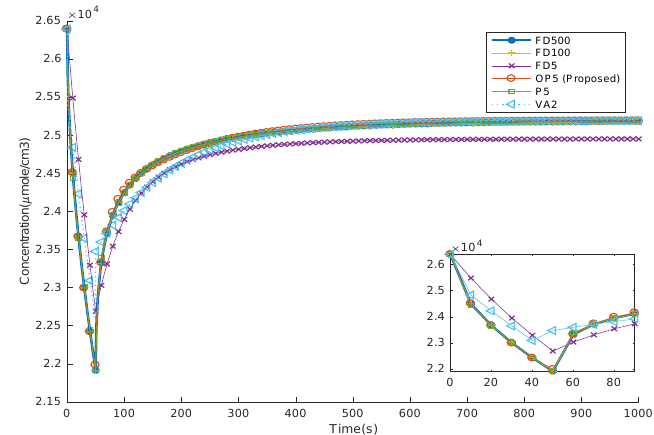
Figure 10. Time domain outputs of different methods for slow dynamics.